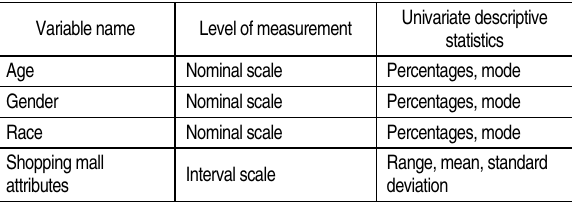
Table 1. Variables used in the data analysis